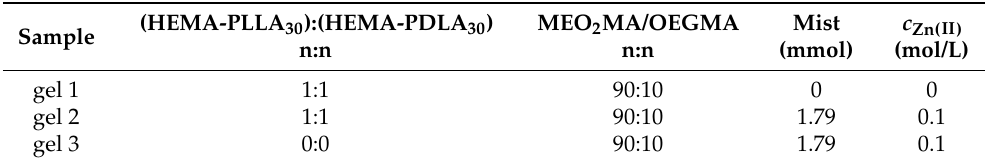
Table 1. Synthesis data of the hydrogen bond hydrogel, hydrogen bond and metal coordination bond double crosslinking hydrogel, metal coordination bond hydrogel.